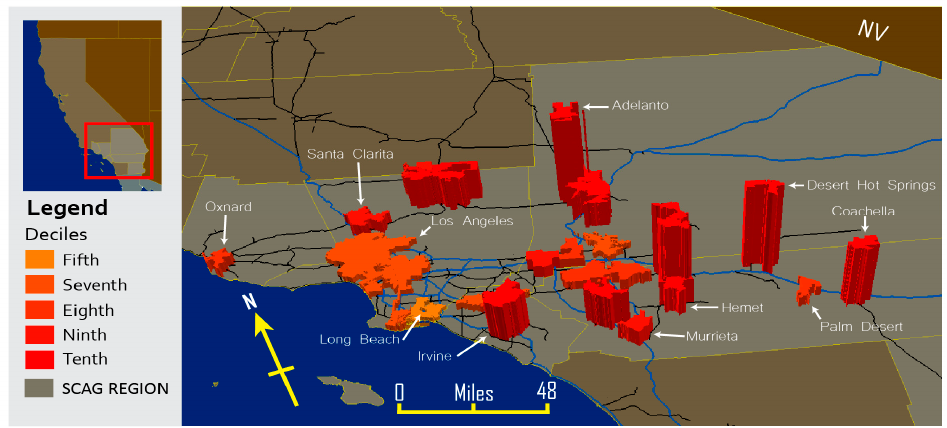
Figure 4. Map of the Los Angeles Region Cities that received 50% of the RHNA Households (RHH). SCAG’s assignment of RHH to these 25 cities supports Baer’s assertion that cities with access to vacant land would shoulder the burden of the region’s future housing growth, as noted by these cities’ deciles. Note that the extrusion heights are not to scale. Source. SCAG.